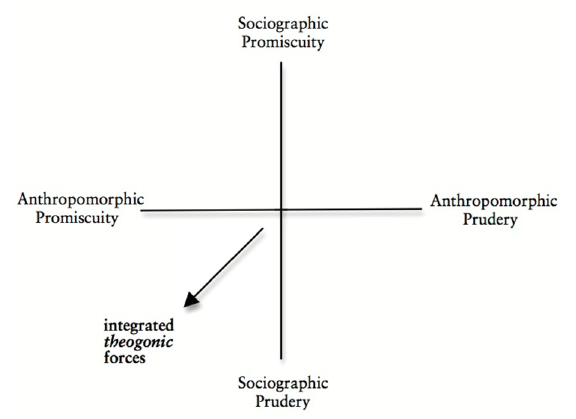
Figure 1. Theogonic